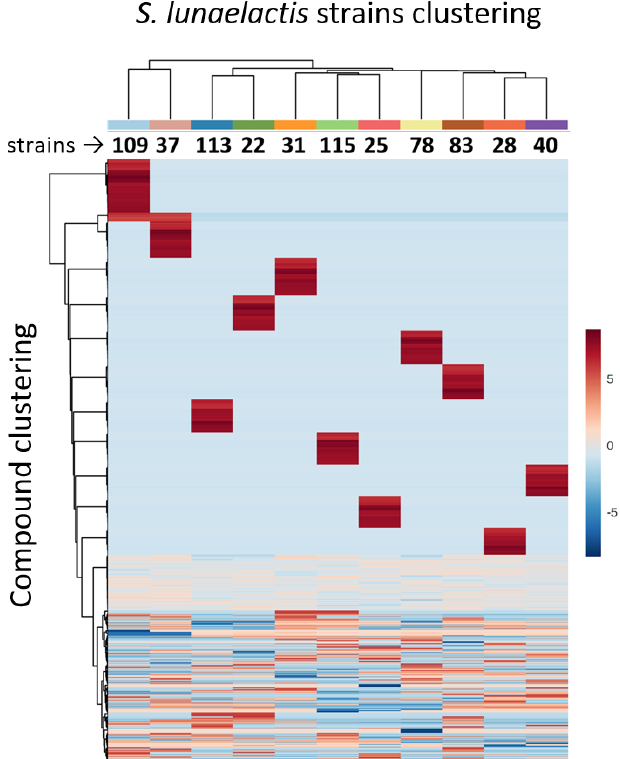
Figure 10. Metabolite profiling of S. lunaelactis strains. The heatmap displays all metabolites identified in the crude extracts of 11 S. lunaelactis strains grown on the ISP7 medium. Metabolites are clustered according to their distribution among the strains. The color gradient represents the MS peak intensity (after generalized log normalization and pareto scaling). Columns refer to S. lunaelactis strains, clustered according to their metabolic profiles. Different metabolic cohorts can be identified. Data transformation, clustering, and figures were generated using R package MetaboAnalyst 3.0 [39].